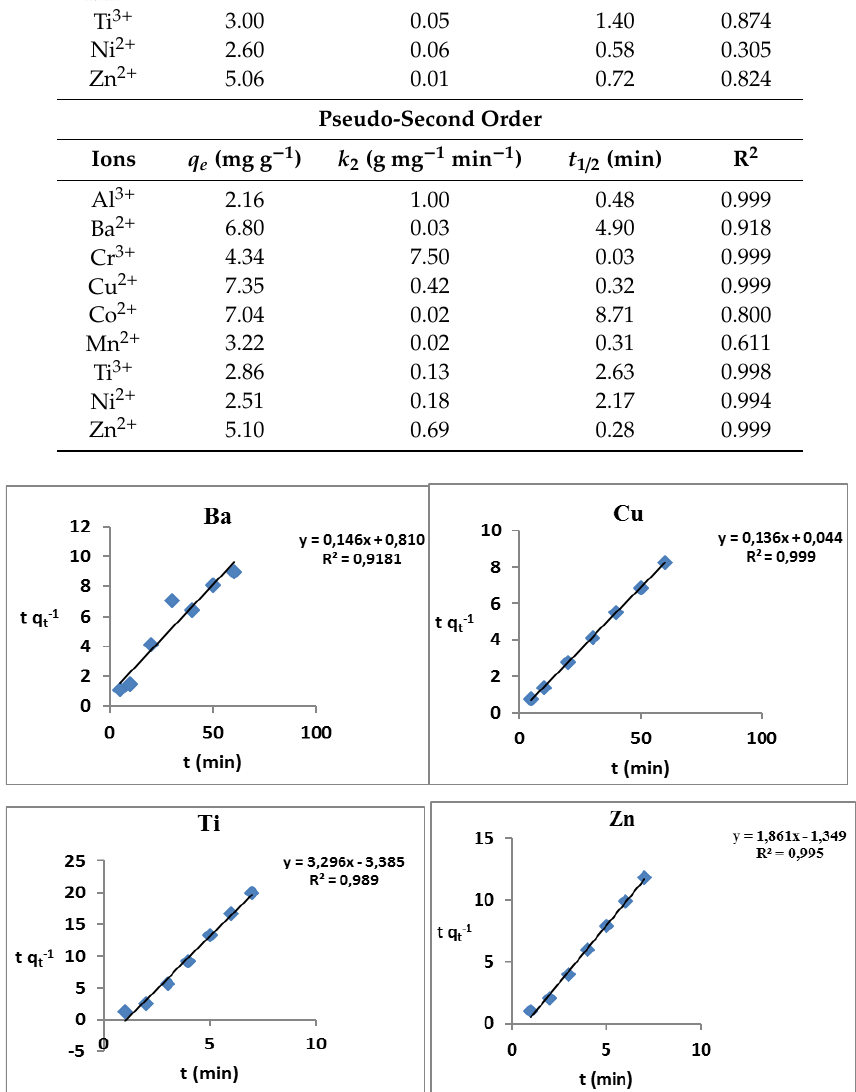
Table 5. Kinetic parameters for intra particle diffusion. Ions